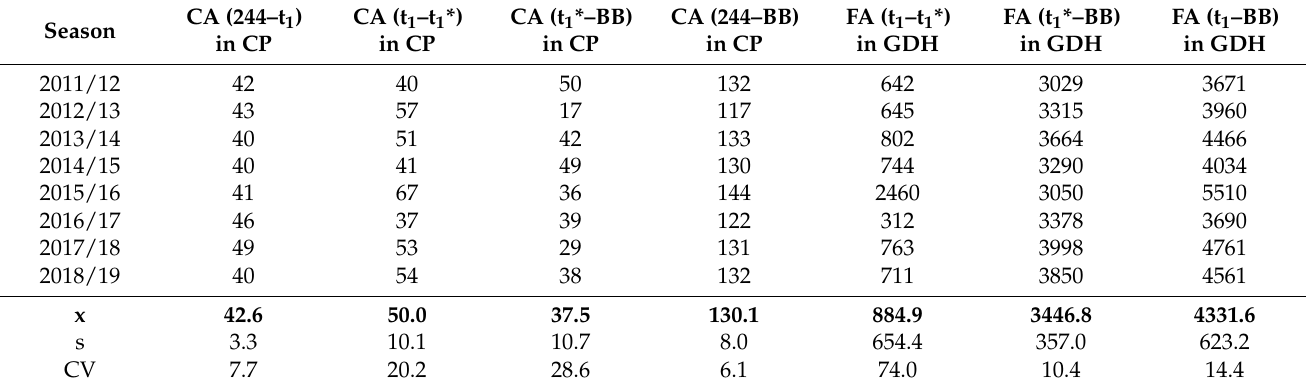
Table 2. Chill (CA) and forcing (FA) accumulation in different phases, 2011/12–2018/19; 1 September—endodormancy release (DOY 244–t 1 ), ecodormancy phase (t 1 –t 1 *), ontogenetic